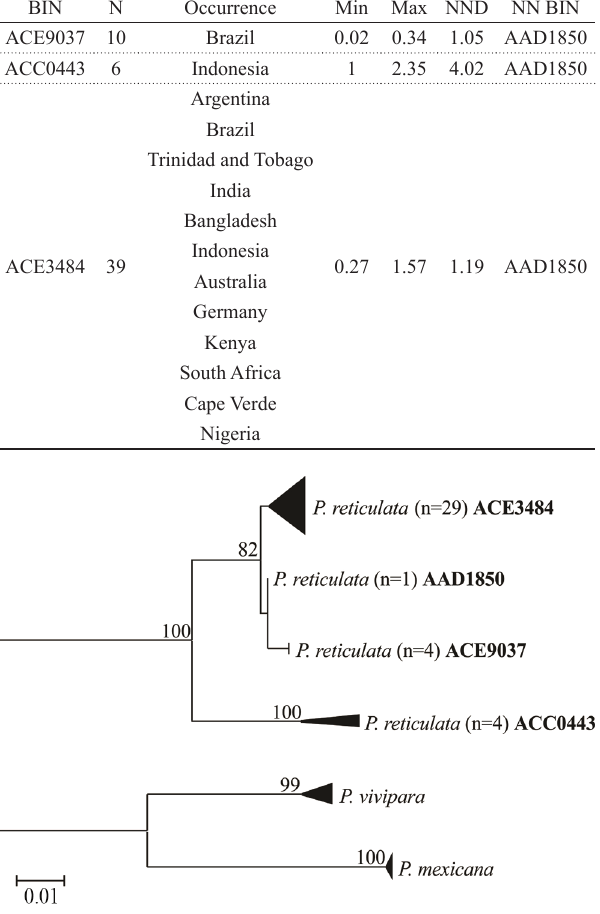
Fig. 3. NJ K2P tree of COI sequences of collected (ACE3484) specimens of Poecilia reticulata . The remaining sequences of this species together with outgroups were gathered from